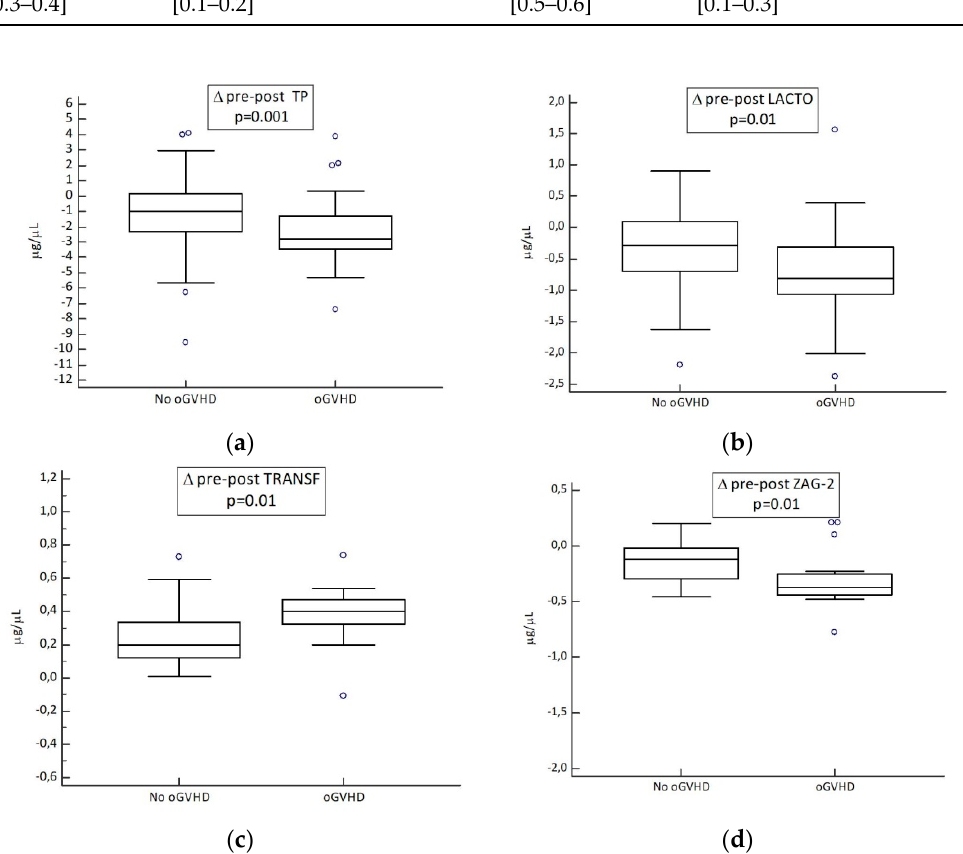
Figure 1. Boxplot representation of pre-post changes in the levels of TP ( a ), LACTO ( b ), TRANSF ( c ), and ZAG-2 ( d ), expressed in µ g/ µ L. Statistically significant differences are present between groups of patients developing ocular graft versus host disease (oGVHD) or not (No oGVHD), for all proteins. Figure 2 summarizes the receiver operating characteristic (ROC) curve analyses per- formed for ∆ pre-post-TP, LACTO, TRANSF, ZAG-2. The area under the curve